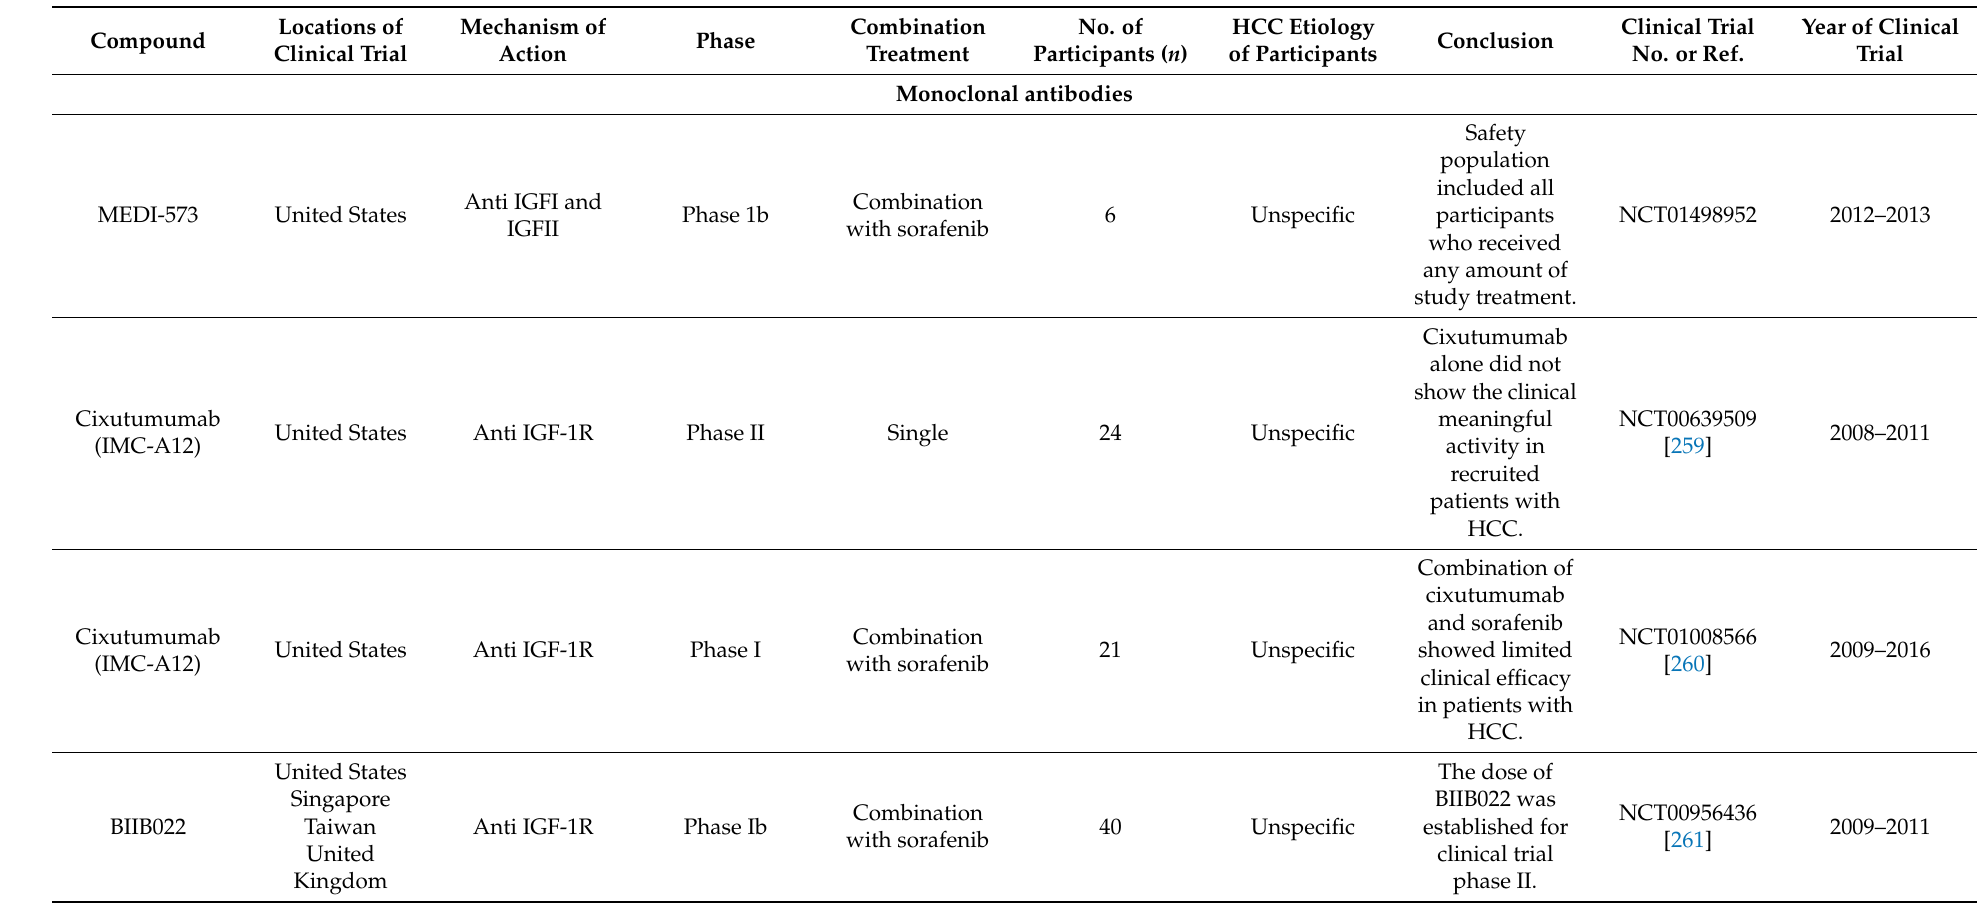
Table 1. Agents that target IGFs/IGF-1R in development for liver cancer